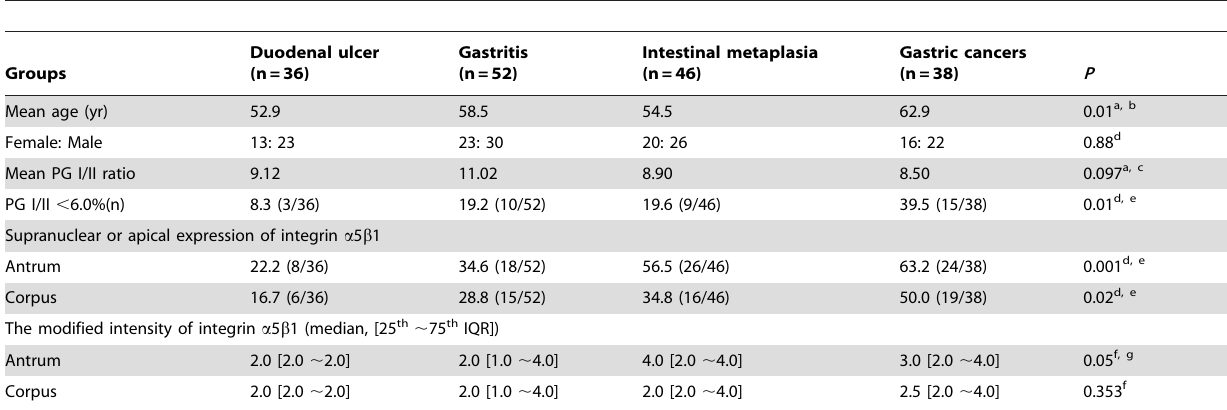
Table 1. The demographic characteristics, pepsinogen I/II ratio, and integrin a 5 b 1 expressions among the different clinical groups with H. pylori infection.